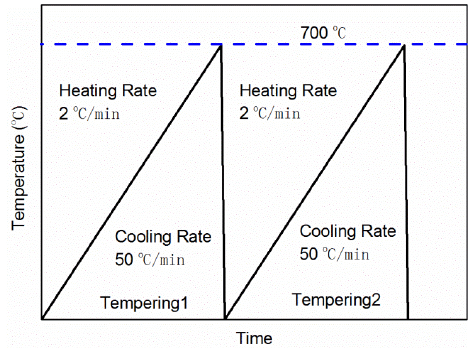
Figure 1. Schematic thermal profile of non-isothermal tempering test.